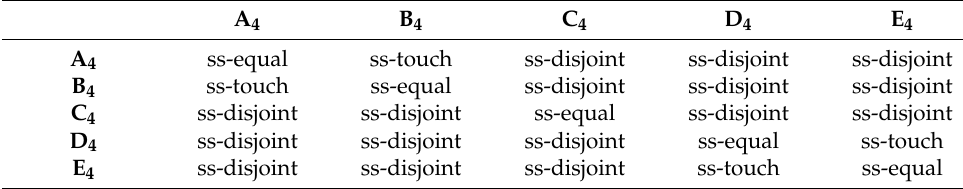
Table 16. Topological relations in the database scene (d) in Figure 17.